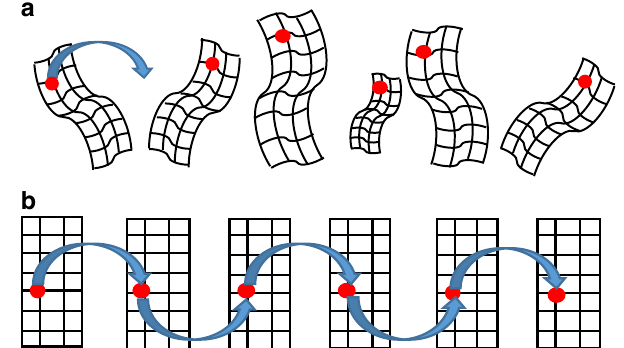
Fig. 2 Challenges for automated data analysis. Missing spatial data point congruency between animals prohibits automated data analysis. a Inherent data point relation between animals is not available because of different animal sizes, positions, and poses. Manual ROI delineation is required for data analysis. b Data congruency between animals is enabled via the BCAM. Automated ROI delineation and data analysis becomes feasible